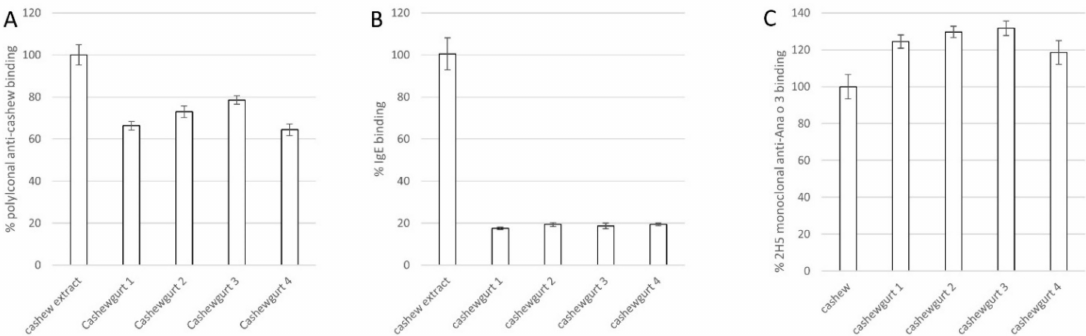
Figure 2. Antibody binding to cashew allergens in soluble Cashewgurt protein . Direct ELISA comparisonofcashewallergenbindingtosolubleCashewgurtproteinwithrabbitpolyclonalanti-cashew ( A ), human cashew-allergic IgE ( B ), and 2H5 monoclonal anti-Ana o 3 ( C ) antibodies; bar graphs represent mean percentage values as compared to antibody binding to cashew nut extract from at least four assays ± percent standard